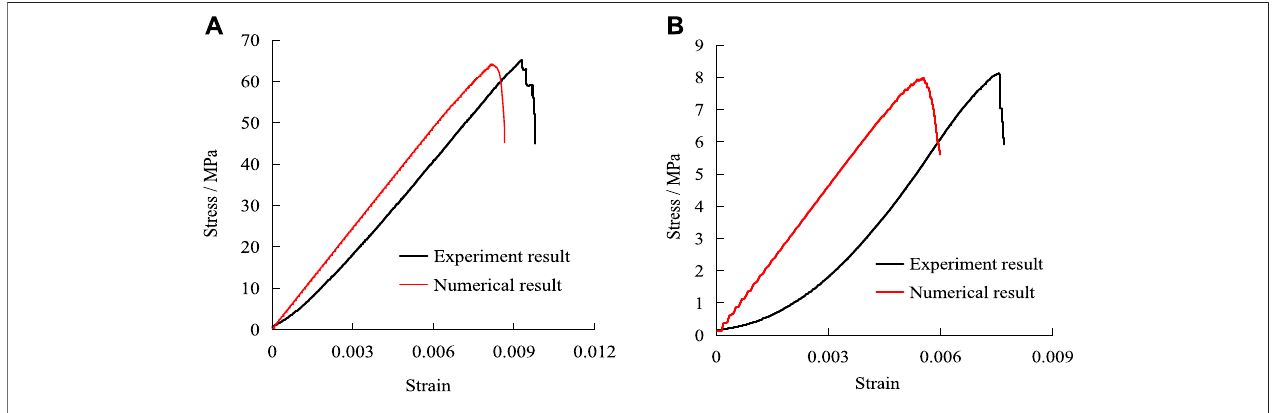
FIGURE 4 | Uniaxial compression stress – strain curve of coal and rock. (A) Rock specimen; (B) Coal specimen.